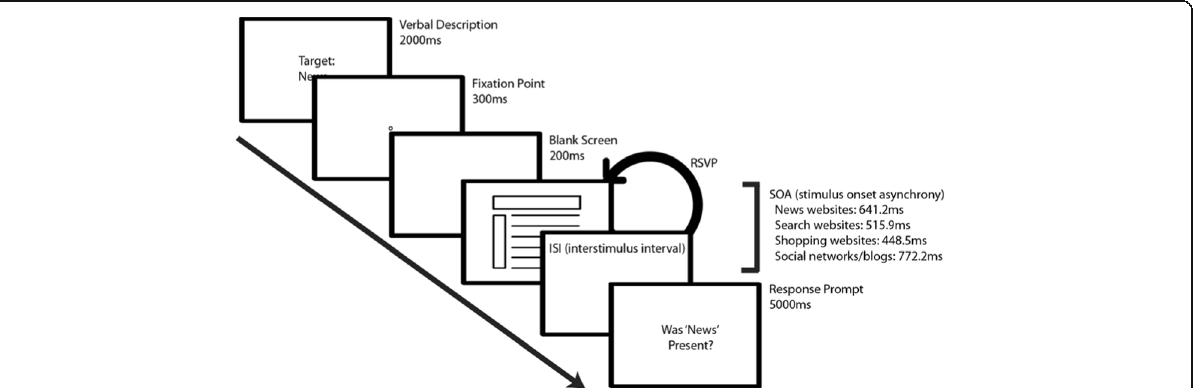
Fig. 10 Sensitivity for detecting websites in each of the different size and resolutions. Error bars are within-subjects 95% confidence intervals (Cousineau, 2005; Morey, 2008)